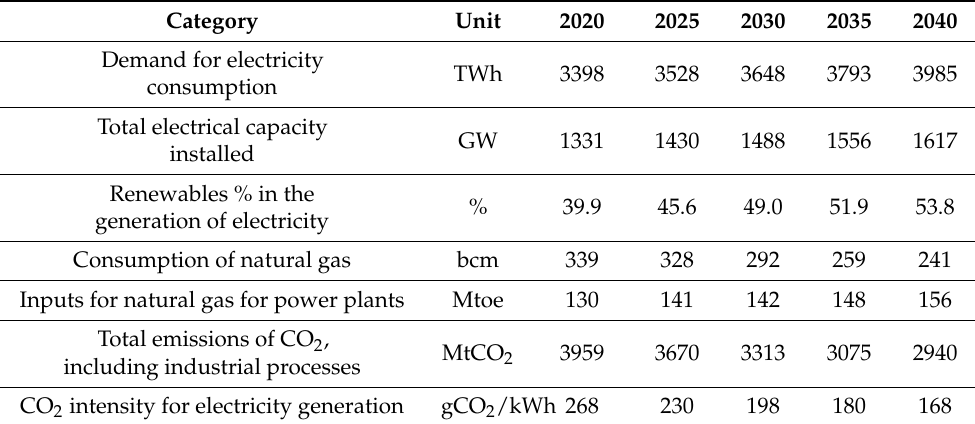
Table 2. Forecast for Europe’s total energy demand from 2020 to 2040 including the categories of the energy sector